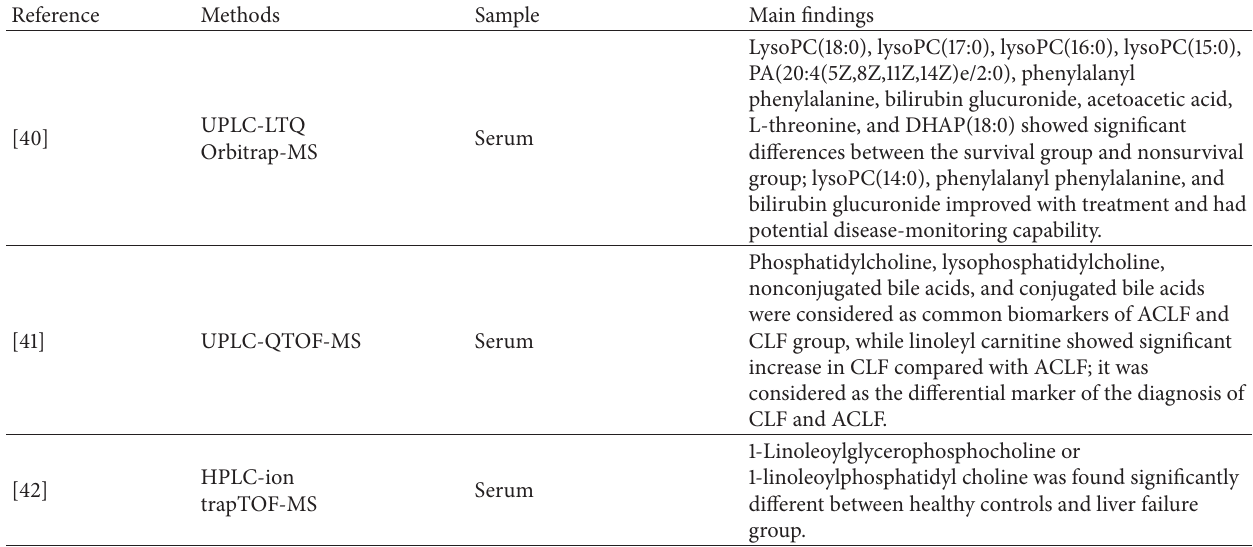
Table 6: The main findings of studies on liver